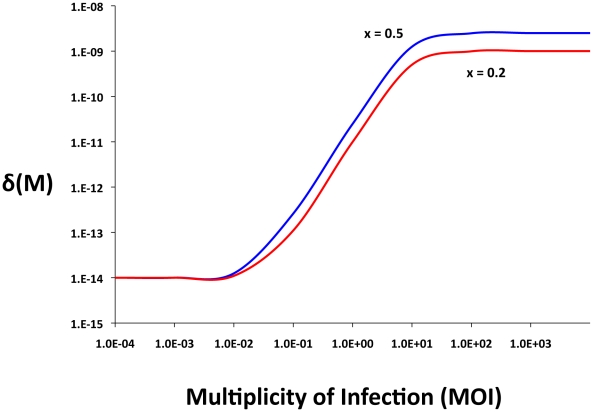
Adsorption rate as a function of the multiplicity of infection (MOI), δMIN = 10−14, δMAX = 5×10−9, x = 0.5, or x = 0.2 q = 102, and n = 2.